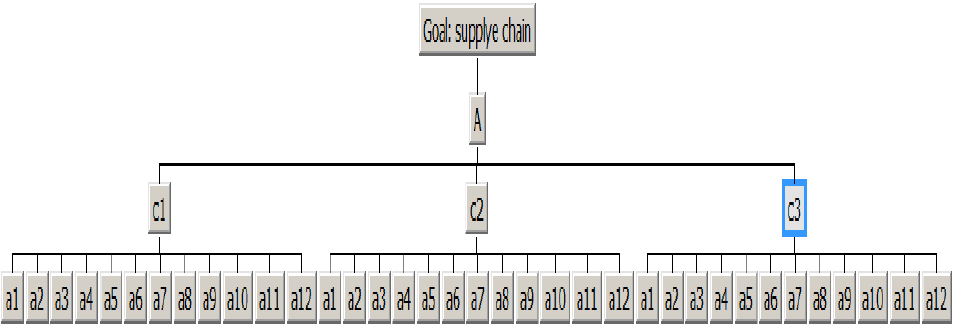
Fig. 1. Step 1: cluster the levels in expert choice software.